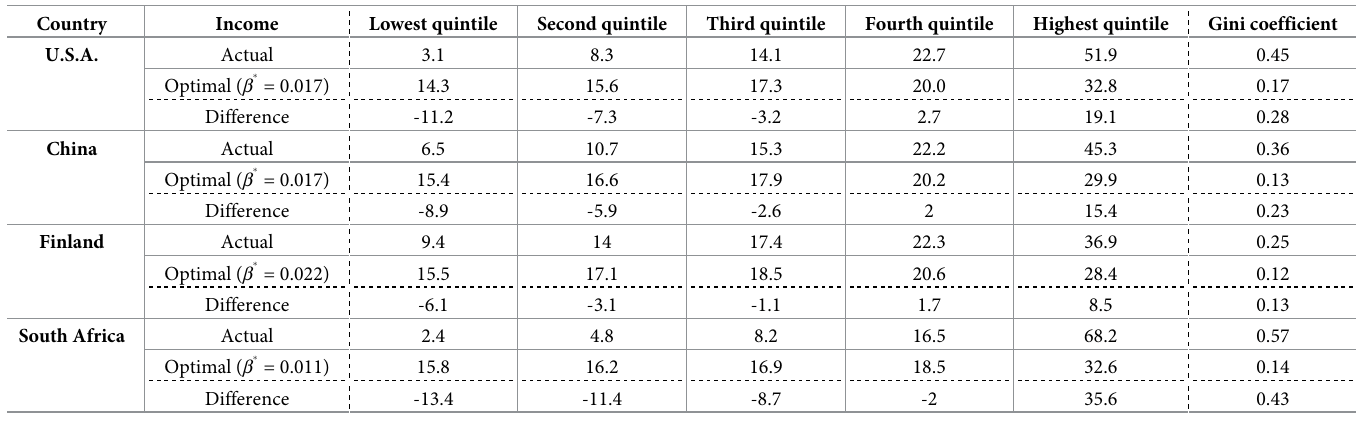
Table 3. Actual and optimal income distributions in four